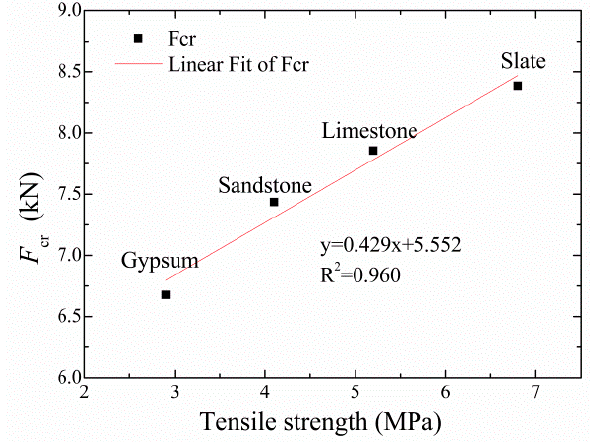
Figure 3. Relationship between critical normal force F cr and the tensile strength.